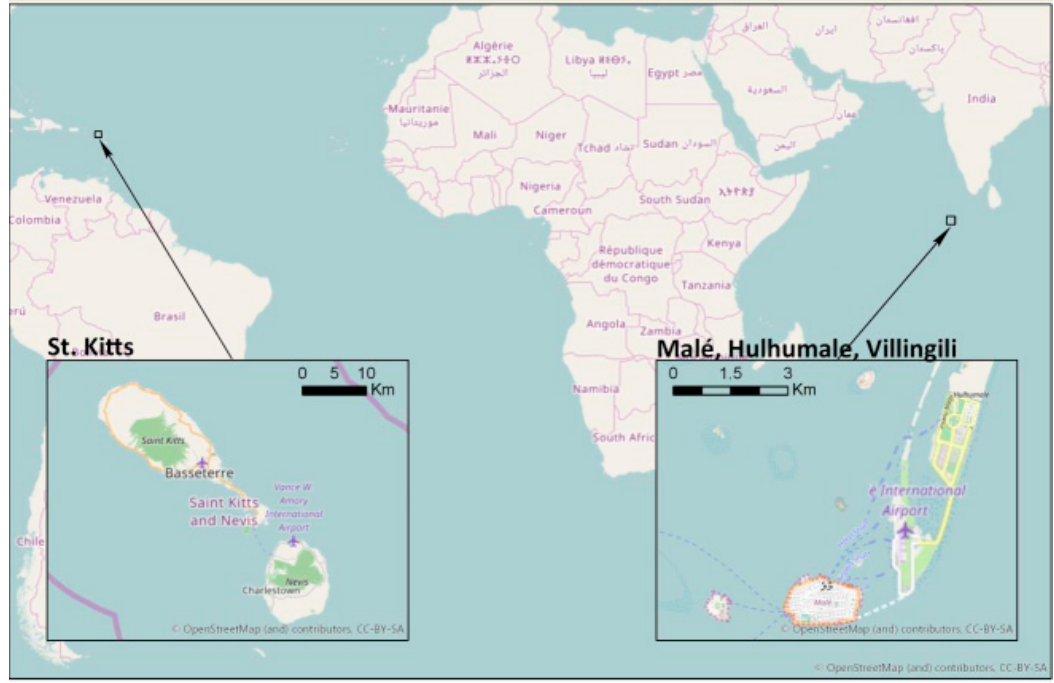
Figure 1. The locations of St. Kitts and Malé, Maldives.